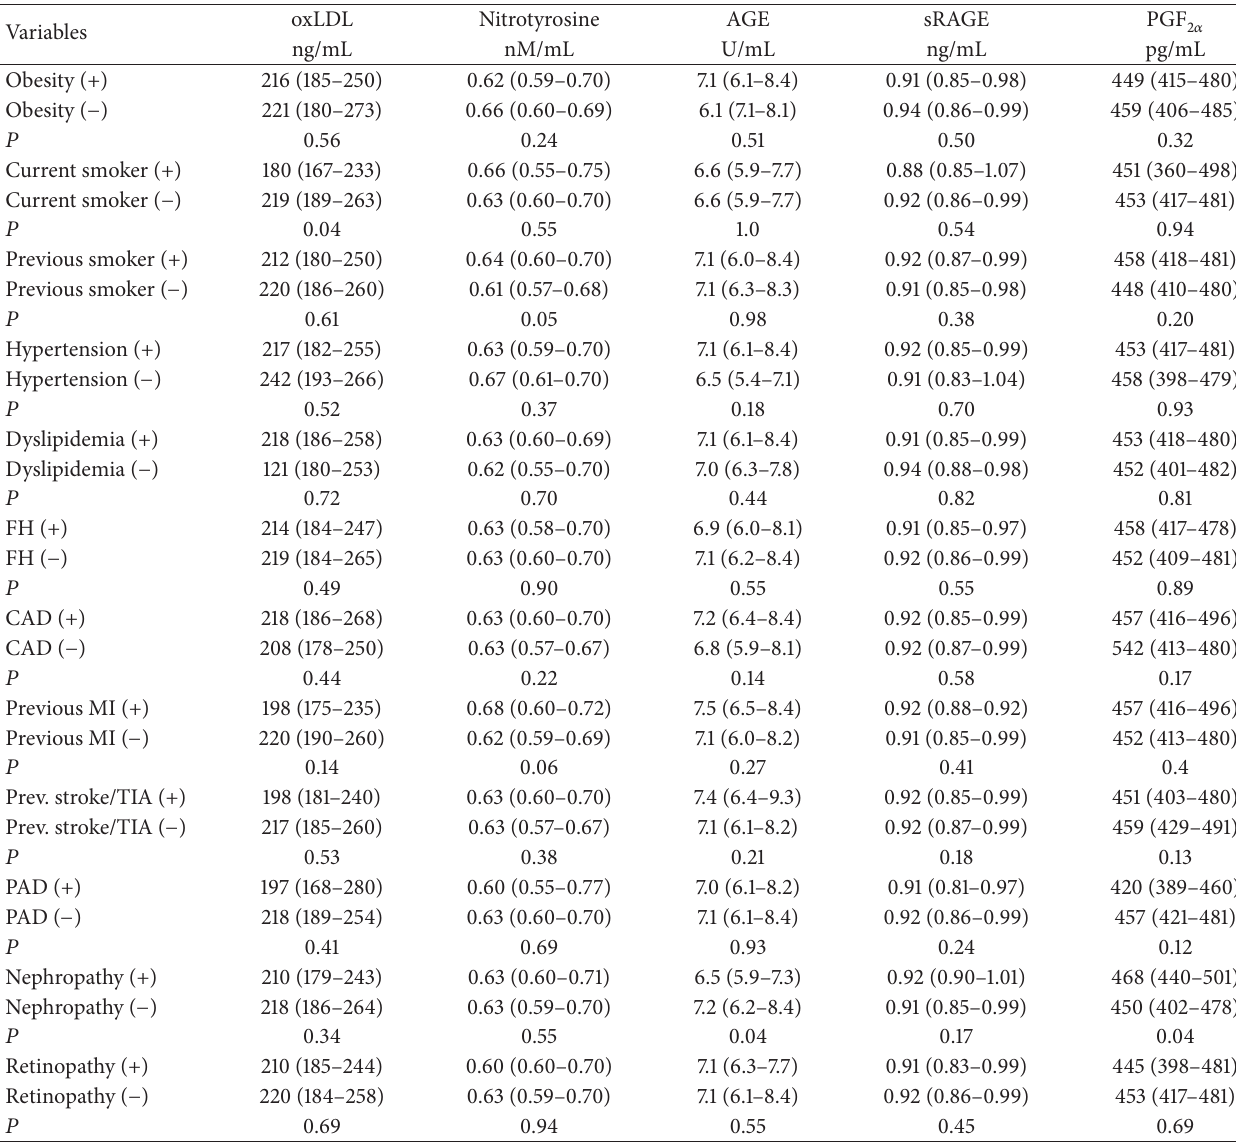
Table 2: Levels of oxidation markers in specific